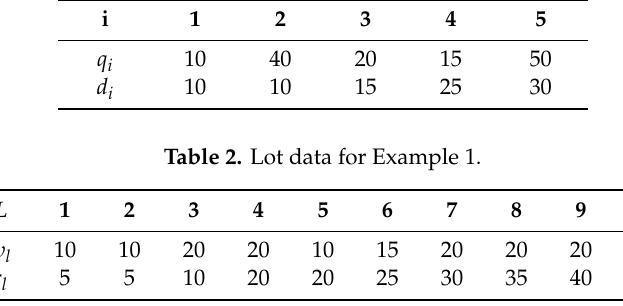
Table 2. Lot data for Example 1.